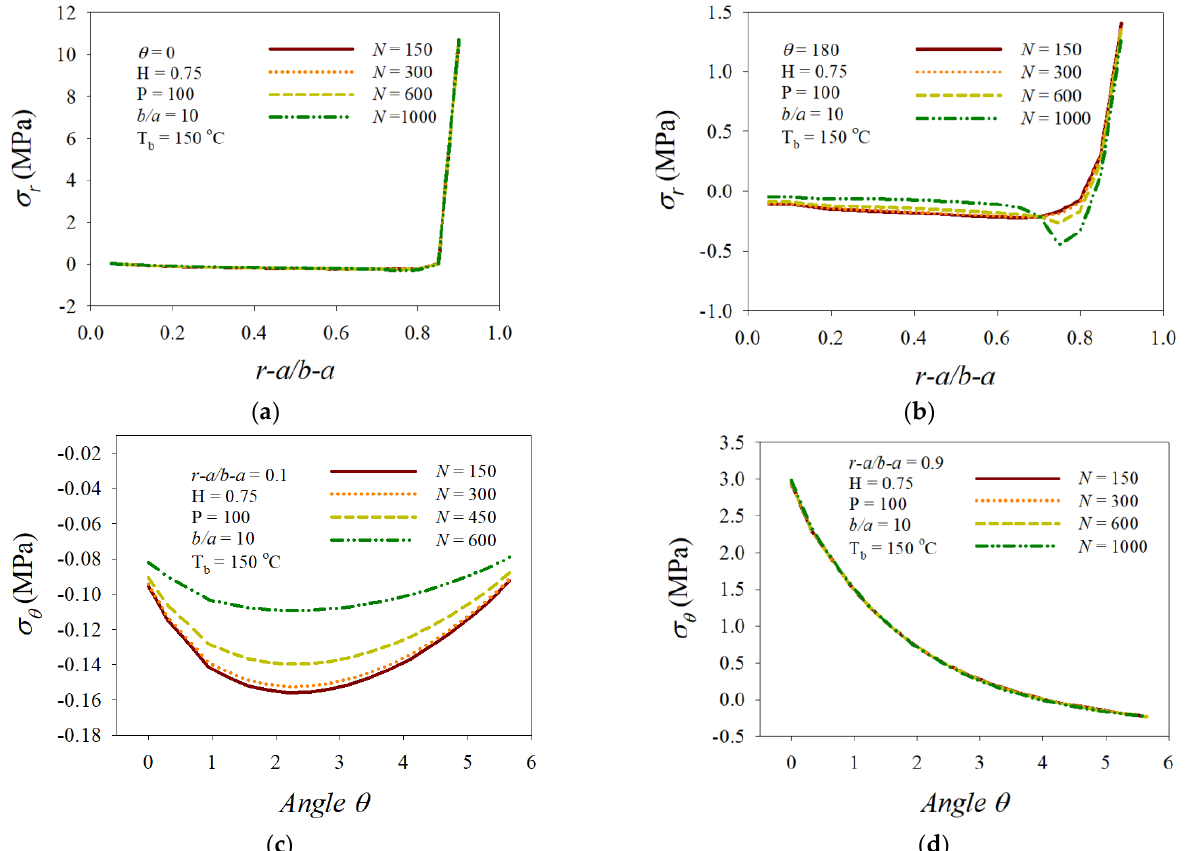
Figure 8. Effects of angular velocity on the components of stress: ( a ) Radial at θ = 0, ( b ) radial at θ = 180 , ( c ) circumferential at (r − a)/(b − a) = 0.1, ( d ) circumferential at (r − a)/(b − a) = 0.9.